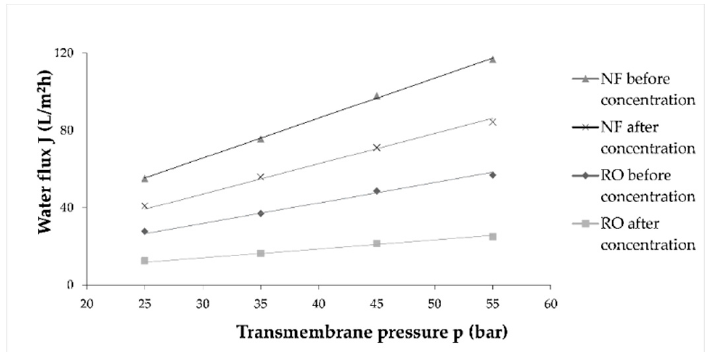
Figure 4. Influence of different transmembrane pressure (bar) on water flux (L/m 2 h) before and after wine concentration by reverse osmosis (RO) and nanofiltration (NF) processes at 55 bar with cooling. Table 1. Fouling index (%) of reverse osmosis (RO) and nanofiltration (NF) membranes at four different